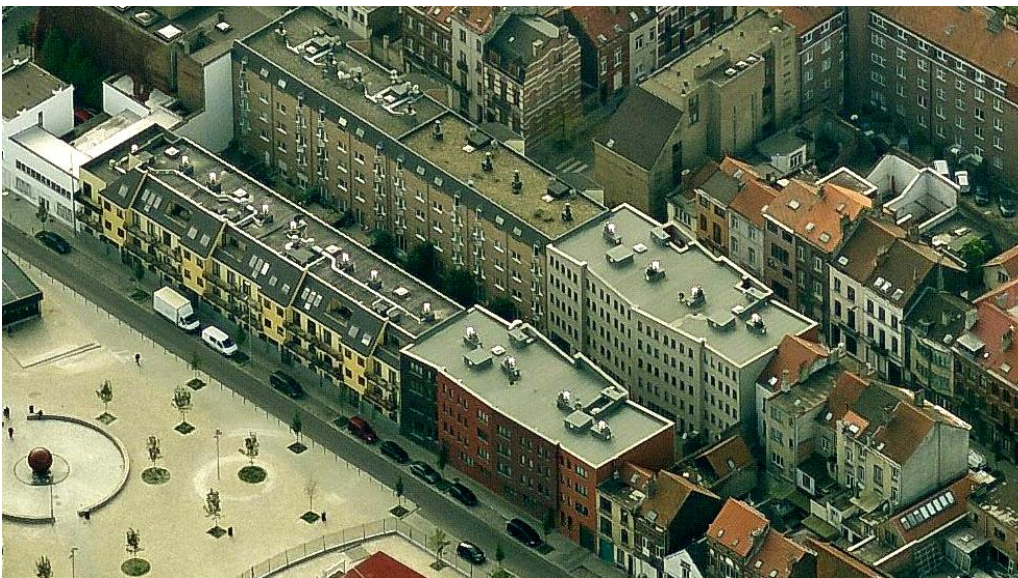
Figure 6 . Amélie, Borsalino, Canotier, Clémenceau (2014). Source data: Bing Maps (2014). the aforementioned housing estate of Peterbos.